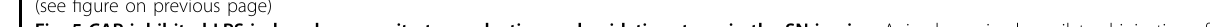
Fig. 5 CAP inhibited LPS-induced peroxynitrate production and oxidative stress in the SN in vivo. Animals received a unilateral injection of PBS or LPS (5 µg/3 µl) into the SN in the absence or presence of CAP (1 mg/kg, i.p.). Animals were then transcardially perfused for further analysis at 1 day after LPS. CAP was administered 30 min before intranigral injection of PBS or LPS; CZP (1 mg/kg, i.p.) was administered 30 min before CAP. a Photomicrograph of nitrotyrosine + cells. Dotted lines indicate the SN pars compacta (SNpc). Insets show highly magni fi ed nitrotyrosine + cells. b Number of nitrotyrosine + cells in the SNpc. The data are presented as the mean ± SEM of 3 – 5 animals per group. ** p < 0.001 compared with PBS- injected SN; # p < 0.05 compared with LPS-injected SN (ANOVA and Student – Newman – Keuls method). c Fluorescence images of nitrotyrosine (red) and TH (green) separately and their merged signals (yellow) in the SNpc. d In situ visualization of LPS-induced O 2- and O 2- -derived oxidant production in the absence or presence of CAP (1 mg/kg, i.p.) or CAP with CZP in the SN. Confocal micrographs show ethidium fl uorescence (red), and the dotted lines indicate the SNpc, which showed degeneration of dopaminergic neurons after LPS treatment. e SN tissues adjacent to those used in a – c were prepared for 8-OHdG histochemistry to detect oxidative DNA damage in the SN. Dotted lines indicate the SNpc. Lower panels show highly magni fi ed 8-OHdG + cells. Scale bars: a, d, e (upper), 200 µm; c , 25 µm; e (lower), 50 µm. The results represent 3 to 4 animals per